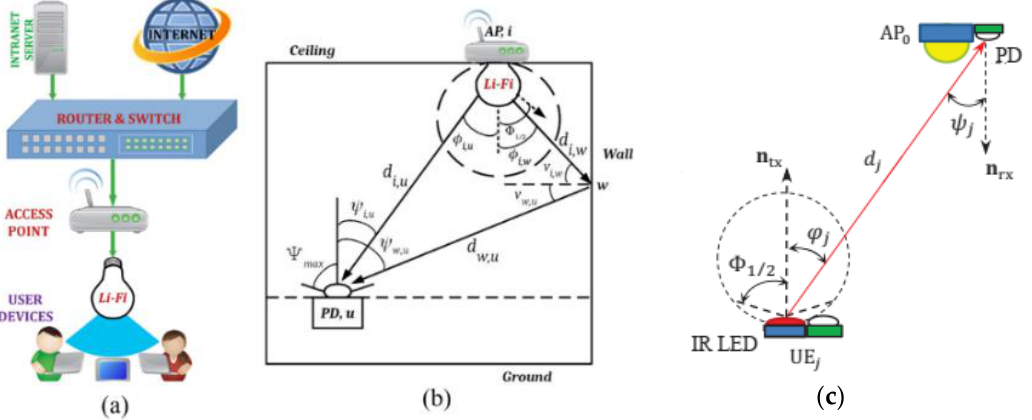
Figure 32. ( a ) Li-Fi downlink configuration; and ( b ) indoor Li-Fi downlink propagation geometry; ( c ) Indoor Li-Fi uplink propagation geometry.